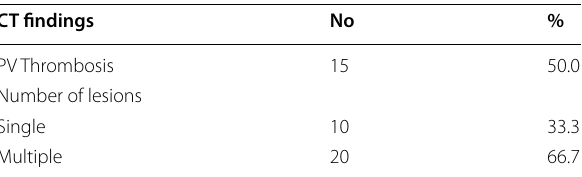
Table 3 Distribution of the studied cases according to CT findings in HCC group (n = Table 6. The diagnostic performance, cutoff point, sensitivity, specificity, PPV, NPV, and accuracy for discriminating HCC from liver cirrhosis for ATG5, Becline 1, and AFP were shown in Table 7. Receiver operating characteristic